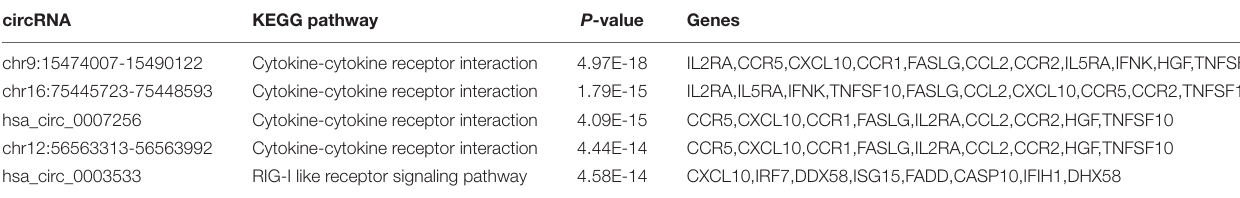
TABLE 1 | The top-five circRNAs with the highest significance level by KEGG enrichment analysis. circRNA KEGG pathway P